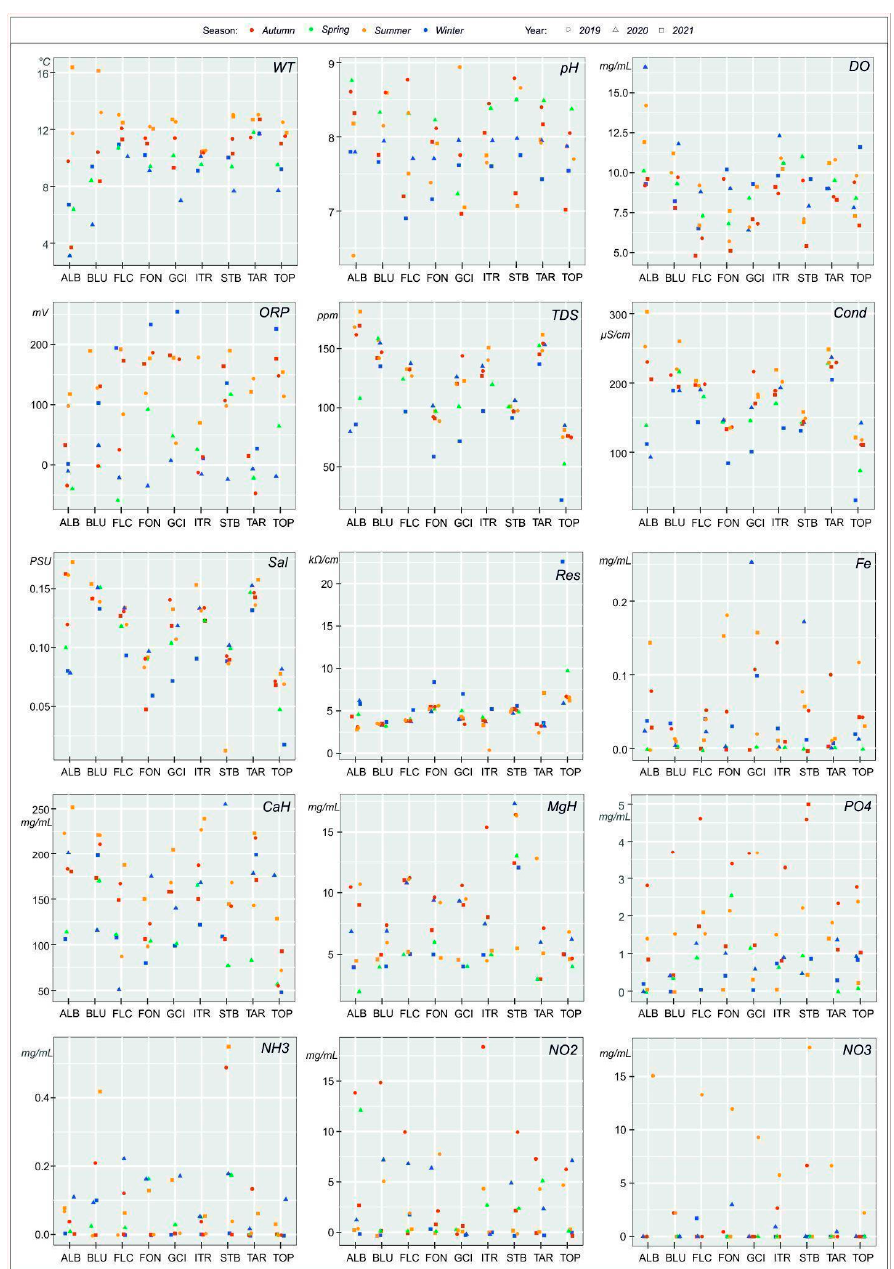
Figure 3. Individual value plots showing seasonal and yearly distribution of the physicochemical parameters of the KSRP freshwater sites. The three-letter acronyms correspond to the sampled freshwater sources (see Table 1).